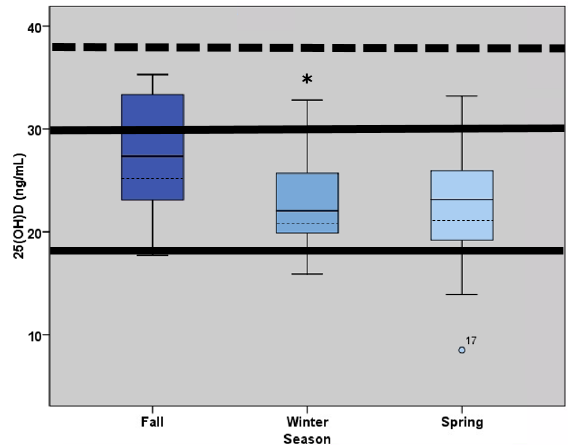
Figure 1. Box plots illustrating the distribution of 25(OH)D concentration (ng/mL) in the fall ( n = 19), winter ( n = 16), and spring ( n = 16). Box extents indicate the 25th and 75th percentile, with the median indicated by a solid dark line and the mean indicated by a dashed line. Central vertical lines (whiskers) extend up to 1.5 interquartile ranges from the end of the box. A circle marks individual points outside of the whiskers indicating a value between 1.5 and 3.0 interquartile ranges of the box. 25(OH)D concentrations <20 ng/mL are considered deficient, concentrations between 20 and 32 ng/mL are considered insufficient (solid horizontal lines), and concentrations >40 ng/mL are considered optimal. * Significant decrease in 25(OH)D observed between fall and winter ( p < 0.001), reported as mean ± SD.